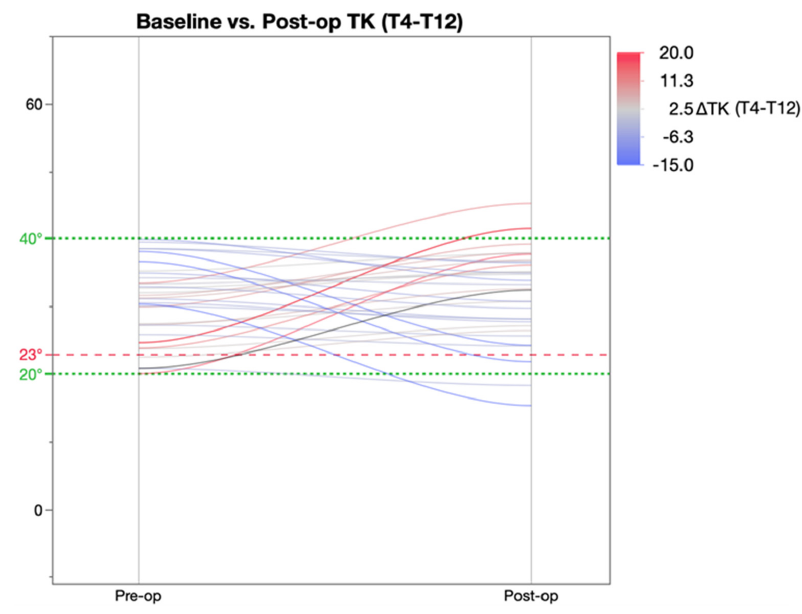
Figure 3. Pre and post-op kyphosis in patients with baseline TK of 20–40 degrees.